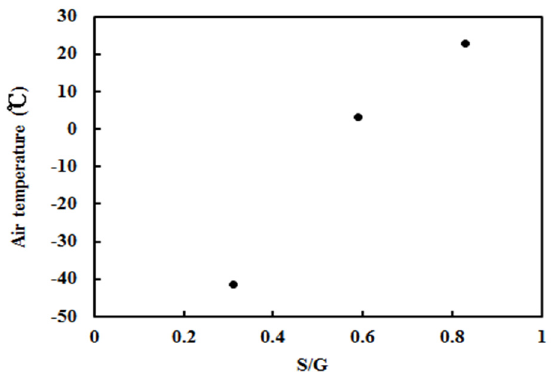
Figure 15. Scatter plot of the annual averages of air temperature and S/G under all-sky conditions at three sites (Sodankyla, Dome C, and Qianyanzhou).